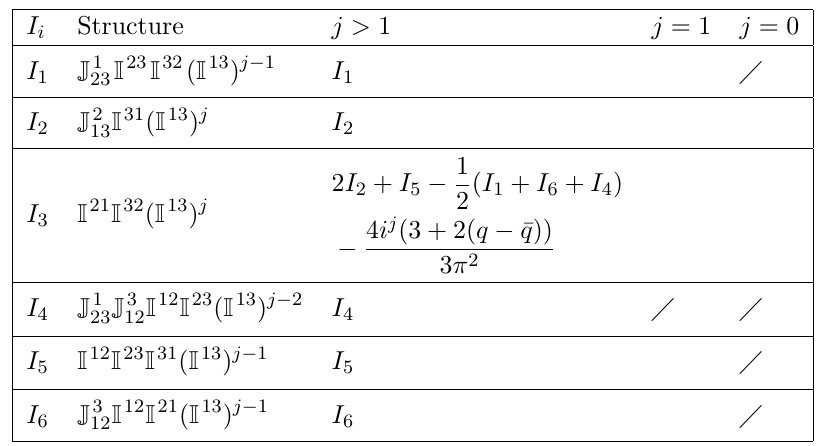
Table 4 . Ward identities of the R-current for the correlator R-charge 2 ( q (cid:22) q )+1 and is assumed to be unit normalized. If O 0 = QO the terms not proportional 3 (cid:0) to I k must be rescaled by c . The unbarred entries in the j = 1 ; 0 columns are obtained by ( QO ) setting the absent coe(cid:14)cients to zero.